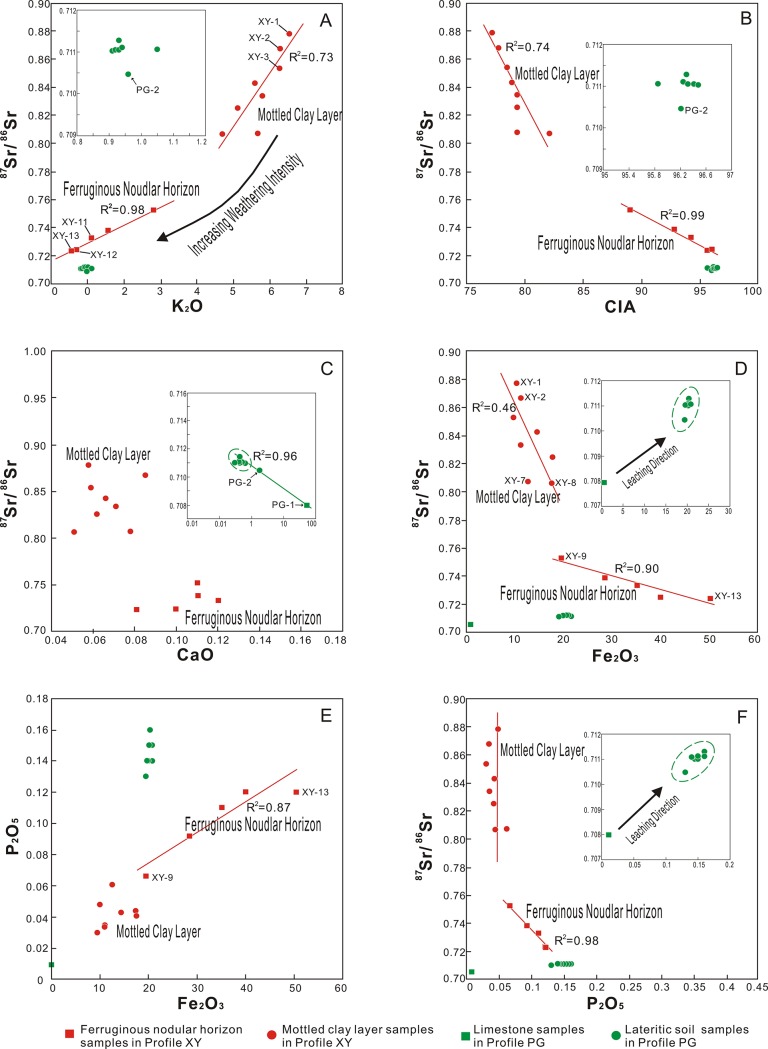
Distributions of
87Sr/86Sr ratio with (A) K2O, (B) CIA value, (C) CaO, (D) Fe2O3, and (F) P2O5
and relationships between (E) Fe2O3
and P2O5. Significant correlations are shown in the plots. CaO refers to the total content.